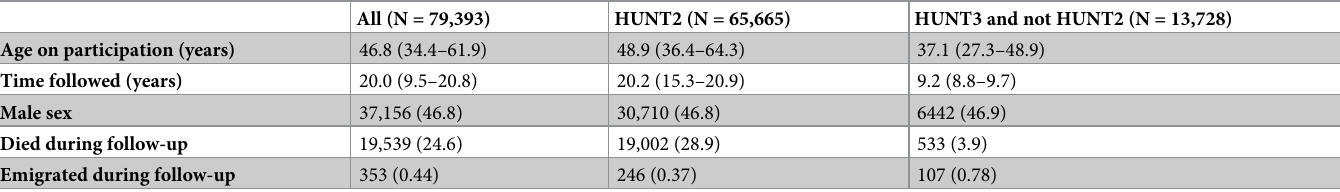
Table 1. Background characteristics of the HUNT2 and HUNT3 population.